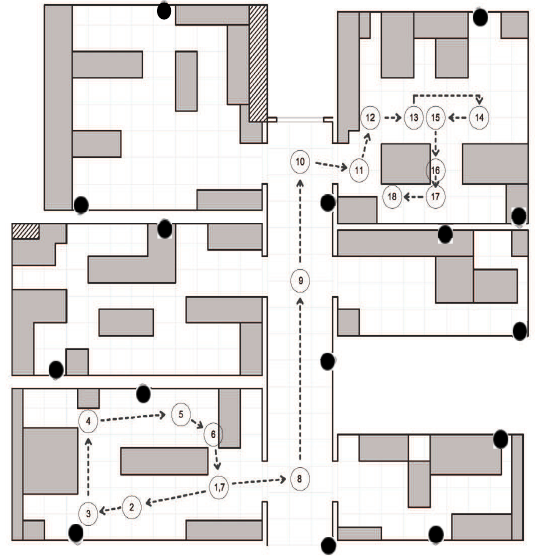
Figure 4. Deployed anchors and the first path: two rooms and the hallway are used during this measure.